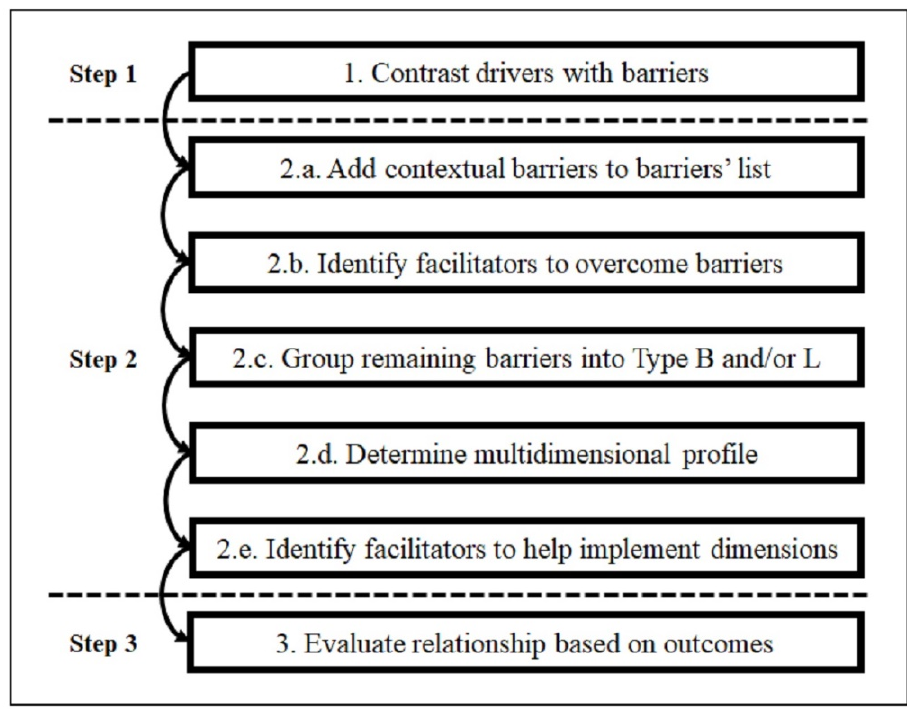
Figure 6. The Inter-firm Relational Framework.